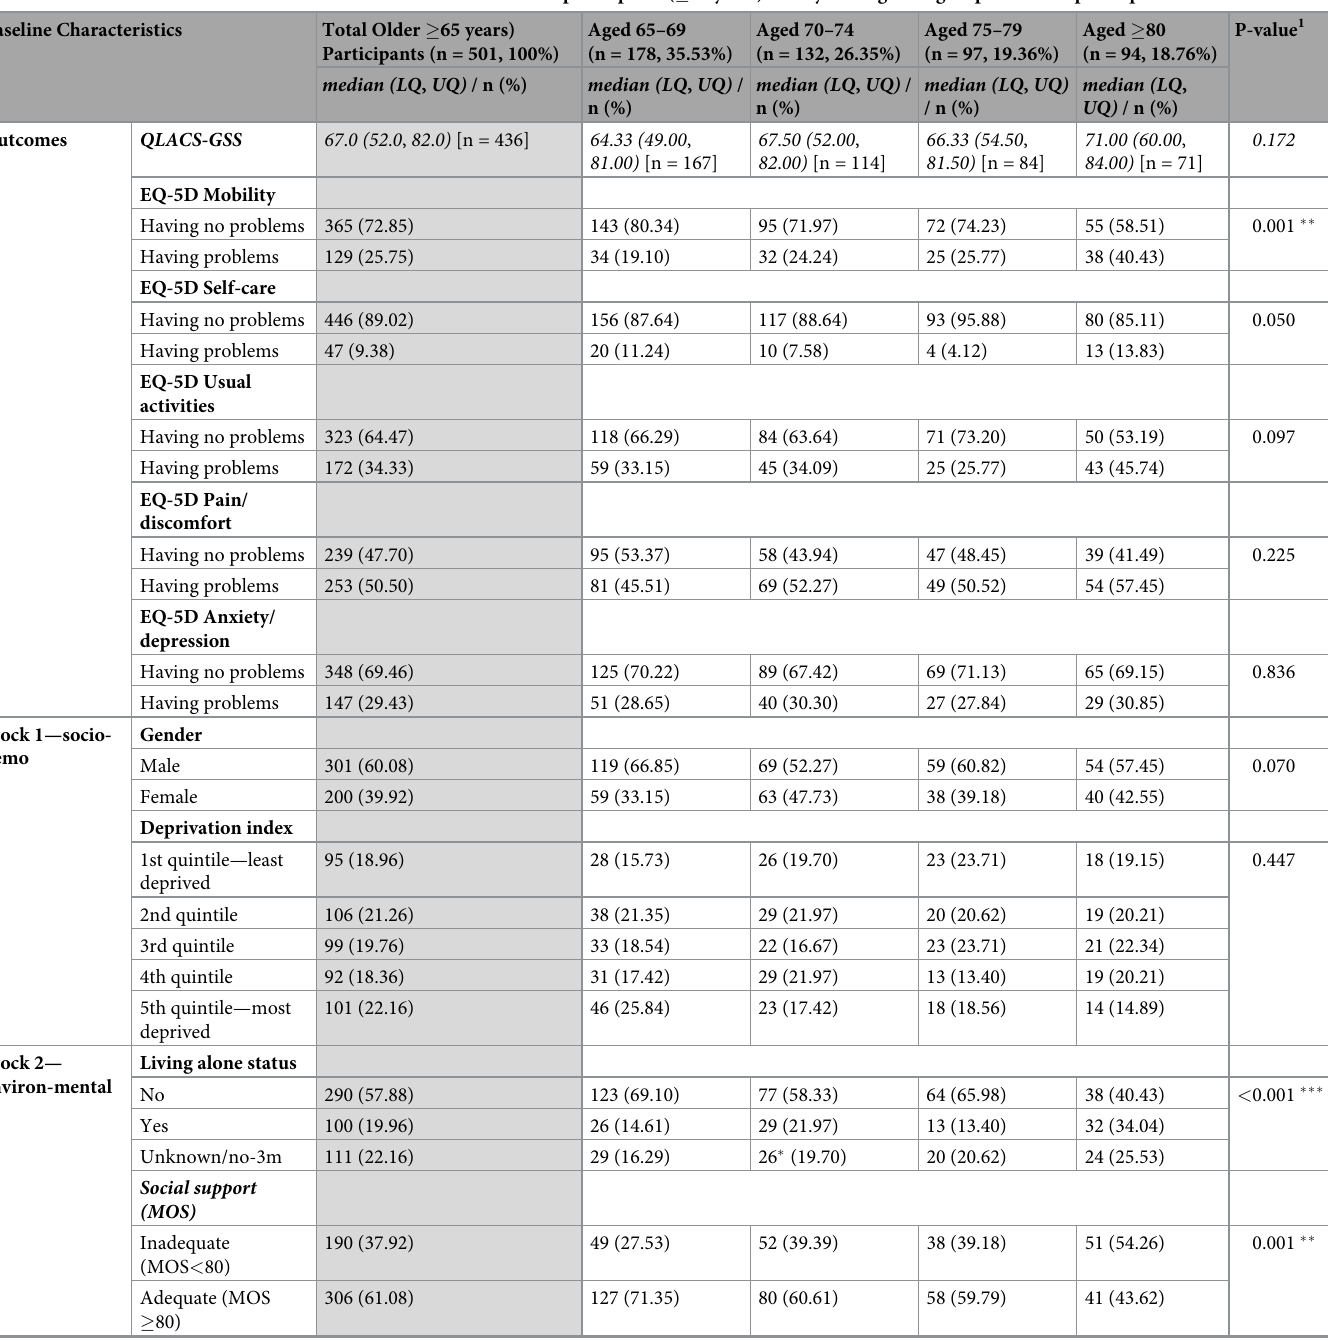
Table 1. Distribution of baseline characteristics for total older CREW participants ( � 65 years) and by four age sub-groups for older participants. Baseline